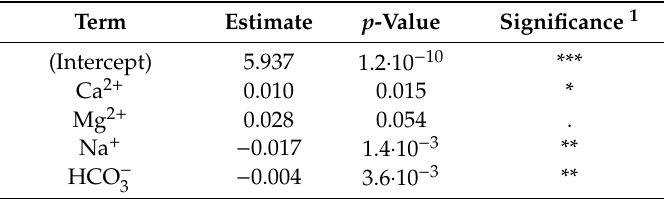
Table 4. Hedonic analysis of taste.